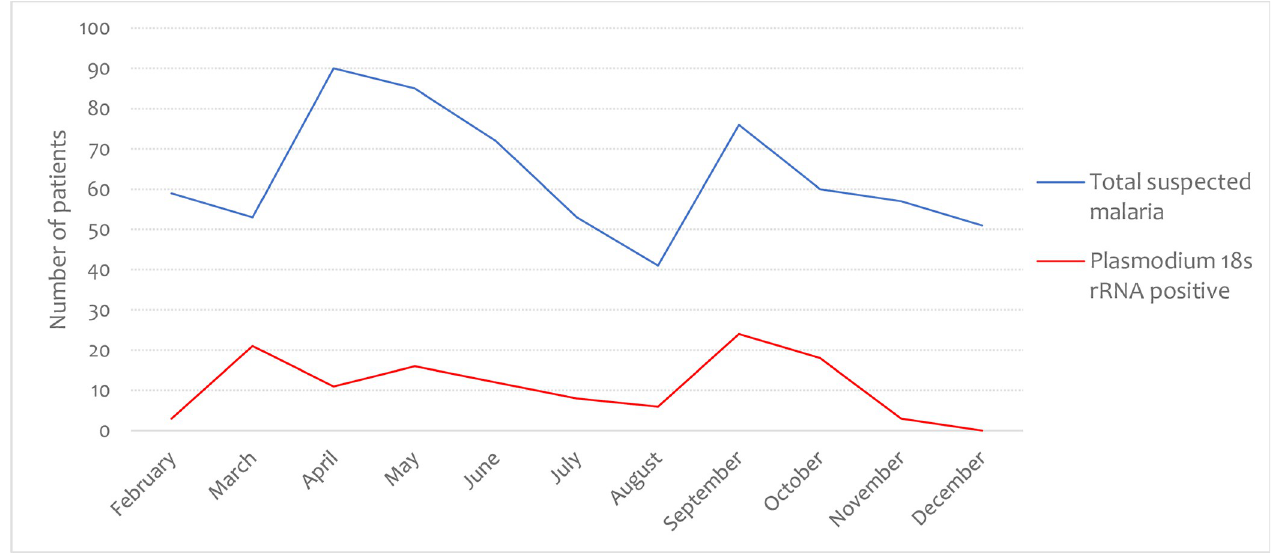
Fig 2. Monthly trends in suspected and Plasmodium 18s rRNA positive cases. Major rainfall–April–June, minor rainfall–March, September and October, no or very low rains—July, August, November–February.